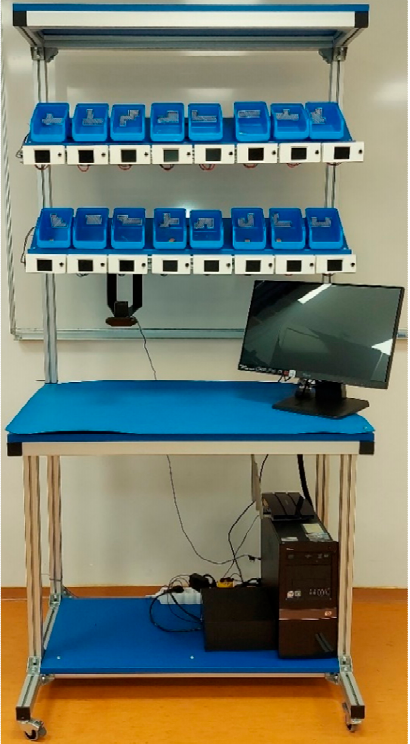
Figure 2. The workbench.